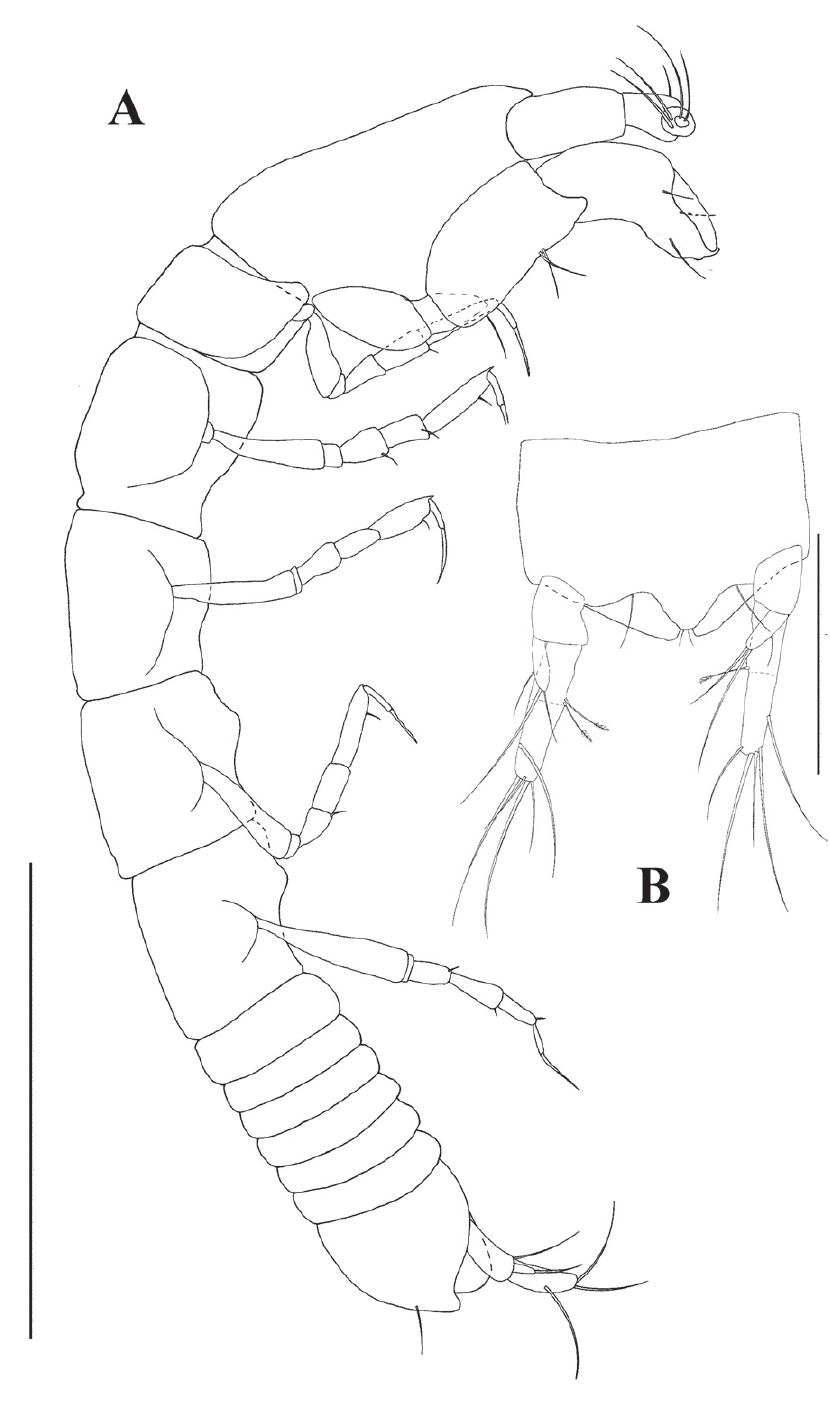
Figure 8. Robustochelia pacifi ca sp. n. Holotype A lateral view B Pleotelson and uropods. Scale bars 0.5